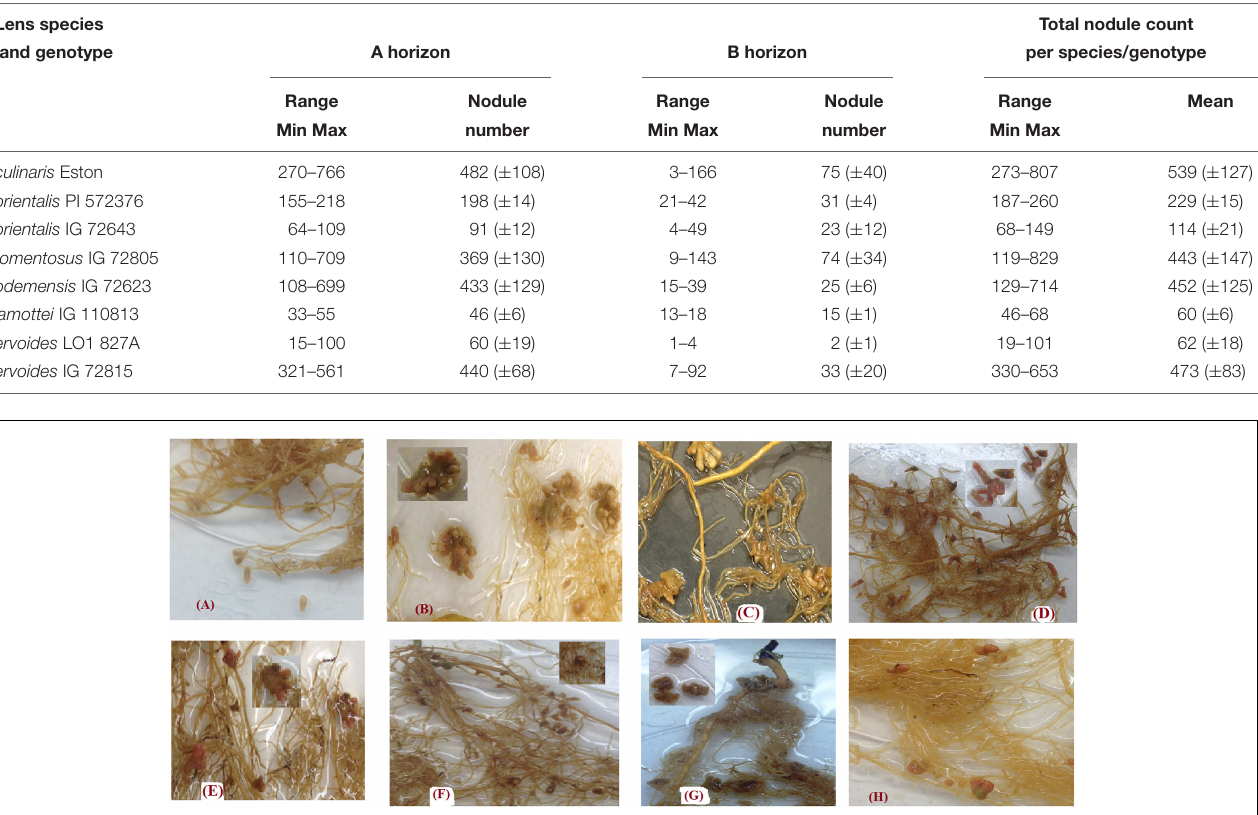
FIGURE 7 | Variations in nodule shapes found in the root systems of Lens culinaris Eston and seven wild lentil genotypes inoculated with strains of Rhizobium leguminarum ( Rhizobium leguminosarum biovar viceae strain 1435; Nodulator XL SCG, Becker Underwood, Canada). (A) L. cul . Eston (B) L. orientalis PI